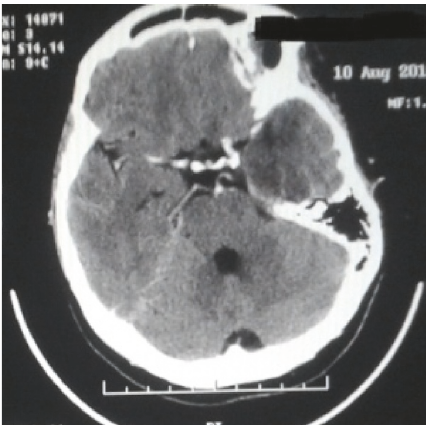
Figure 2: CT brain scan. Hypodense depiction of the left temporal